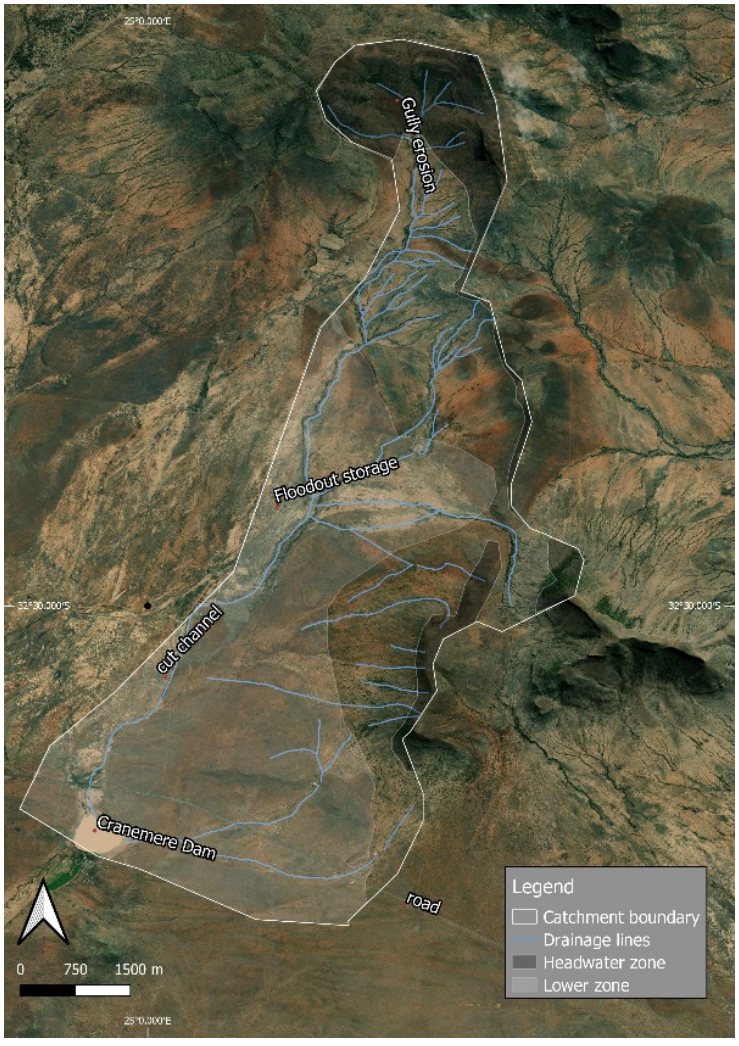
Figure 3. Cranemere dam catchment. The mid-slope zone (not identified) lies between the headwater and lower zones and is characterised by gully erosion.